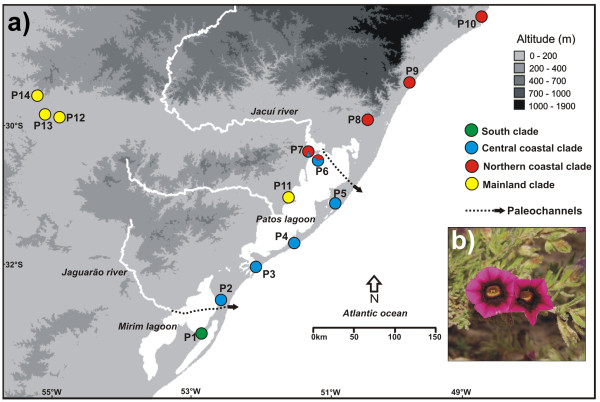
Collection site location. a) Map showing the sampling sites. The colors of the populations are related to the haplogroups identified by the network and Bayesian chronogram. Dotted lines represent paleochannels [40,51]. b)Calibrachoa heterophylla flower.